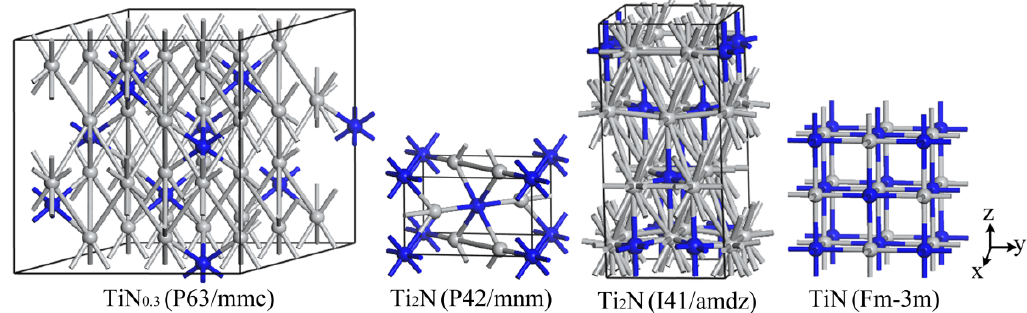
Figure 9. The crystal structures of typical Ti-N compounds, with the gray balls and blue balls representing Ti and N, respectively.